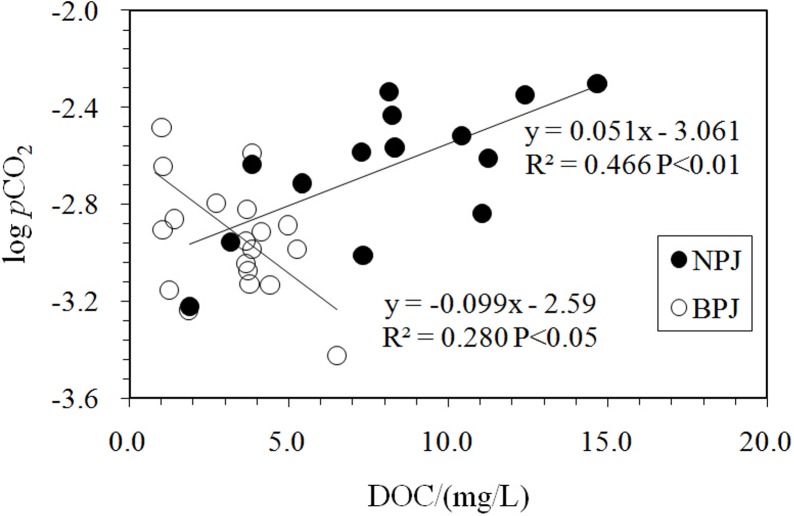
Variation of logPCO2 with dissolved oxygen (DO).Inverse relations were observed for both the Nanpan and Beipan Rivers. logPCO2 represents the logarithmic value of PCO2.